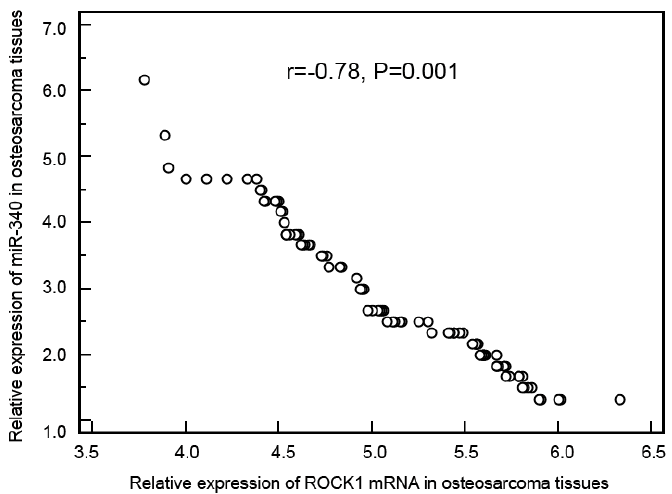
Figure 2. Scatter diagram for the correlation analysis of miR-340 expression and ROCK1 mRNA expression in osteosarcoma